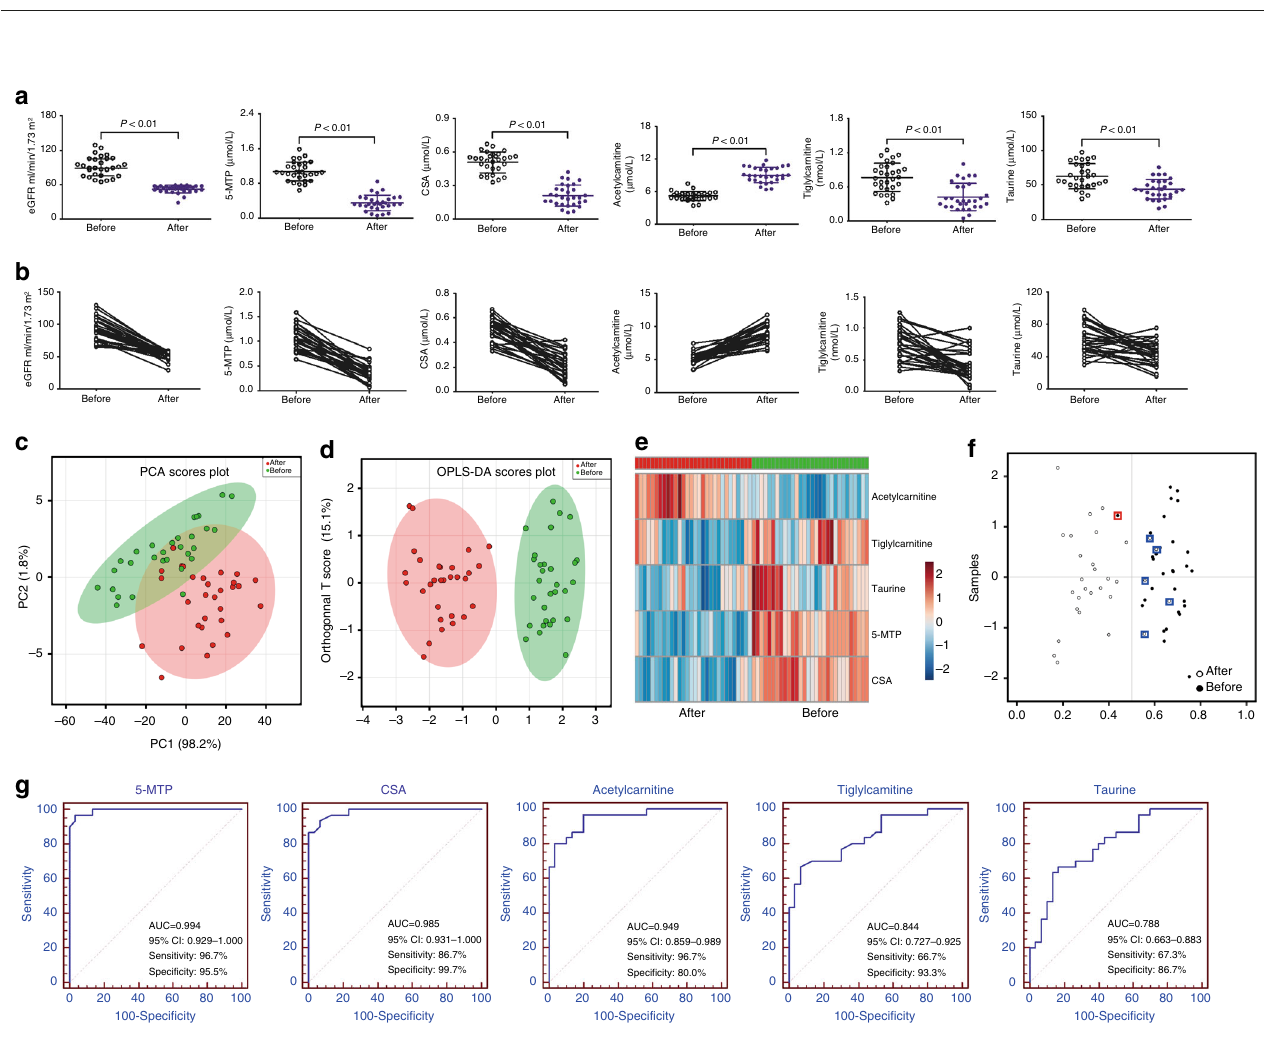
Fig. 3 The fi ve metabolites were further validated by a longitudinal cohort study. a Dot plots of levels of fi ve metabolites including 5-MTP, CSA, acetylcarnitine, tiglylcarnitine and taurine in serum of normal healthy controls and CKD case. They were determined by UPLC-HDMS method. Mean values are presented by horizontal bars. Upper and lower lines indicate standard deviation values. b Dots and lines showing changes of fi ve metabolites in each individual from normal status to CKD case status. c PCA of two components of fi ve metabolites from normal healthy controls and CKD case. d OPLS-DA of fi ve metabolites from normal healthy controls and CKD case. e Heatmap of fi ve metabolites from normal healthy controls and CKD case. f Diagnostic performances of fi ve metabolites from normal healthy controls and CKD case based on the PLS-DA model. The black dots with red squares or black circles with blue squares are for the incorrectly predicted samples in CKD case and normal controls. 27 Out of the 31 CKD case were located in CKD case area (87.1% sensitivity) and 30 out of the 31 normal healthy controls were correctly grouped (96.8% speci fi city). These results demonstrated that the fi ve metabolites show high prediction class probabilities. g Analysis of PLS-DA based ROC curves of fi ve metabolites in normal healthy controls and CKD case from 31 individuals. The associated AUC, 95% con fi dence interval (CI), sensitivity and speci fi city values were indicated. Student ’ s t test was used for the signi fi cance of difference between two groups. OPLS-DA orthogonal partial least squares-discriminant analysis, PCA principal component